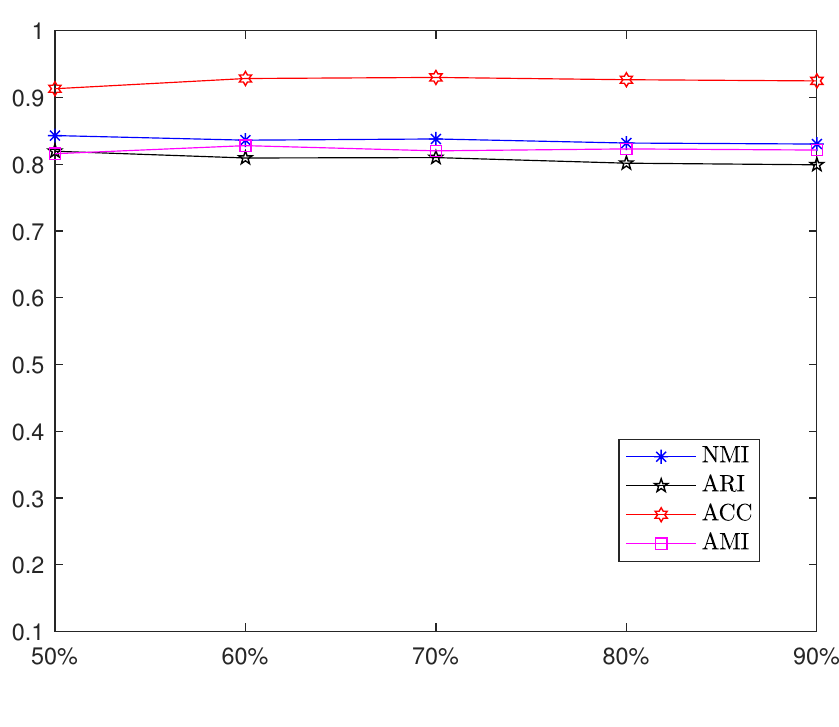
Figure 6. Results of Iris by 3WESP.